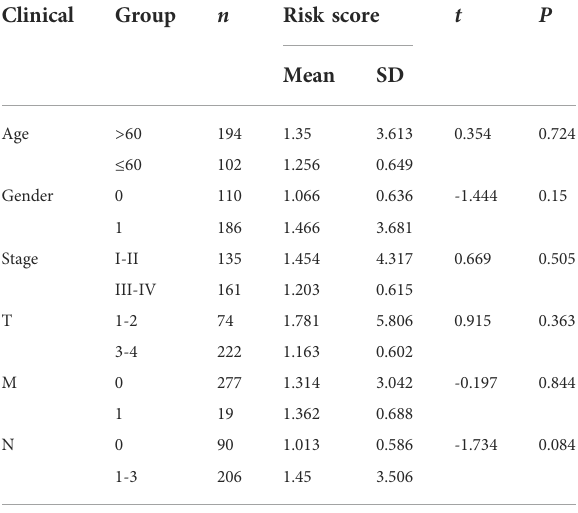
TABLE 3 Clinical in fl uences of risk score signature for TCGA-STAD data. Clinical